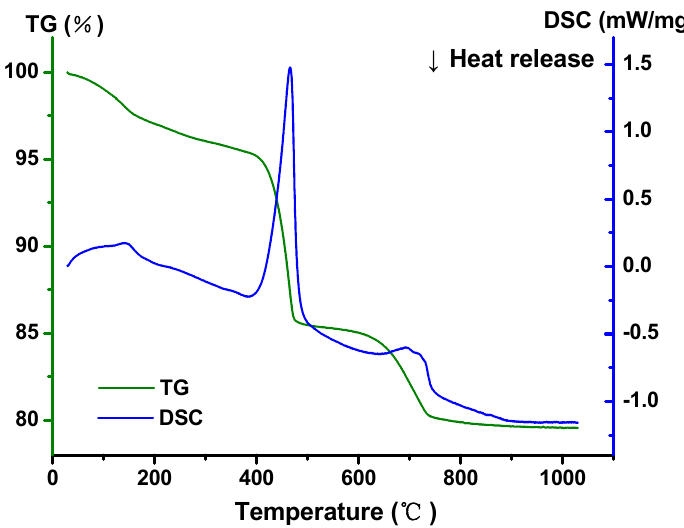
Figure 12. TG-DSC-DTA data of Y 2 SmSbO 7 .